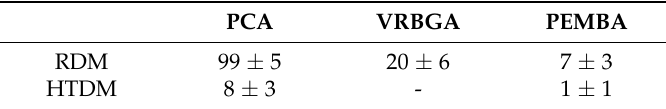
Table 1. Microbiological counts (total aerobic— Plate Count Agar (PCA),